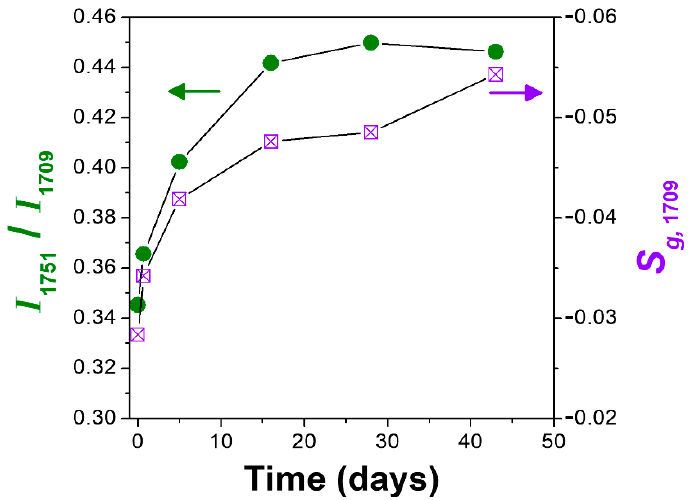
Figure 8. Intensity ratio of the two carbonyl peaks I 1751 / I 1709 , corresponding to isolated and hydrogen bonded HA guest molecules (left scale and green circles), and dichroism of the 1709 cm − 1 peak (right scale and violet squares) versus the guest desorption time, for the ε form film.